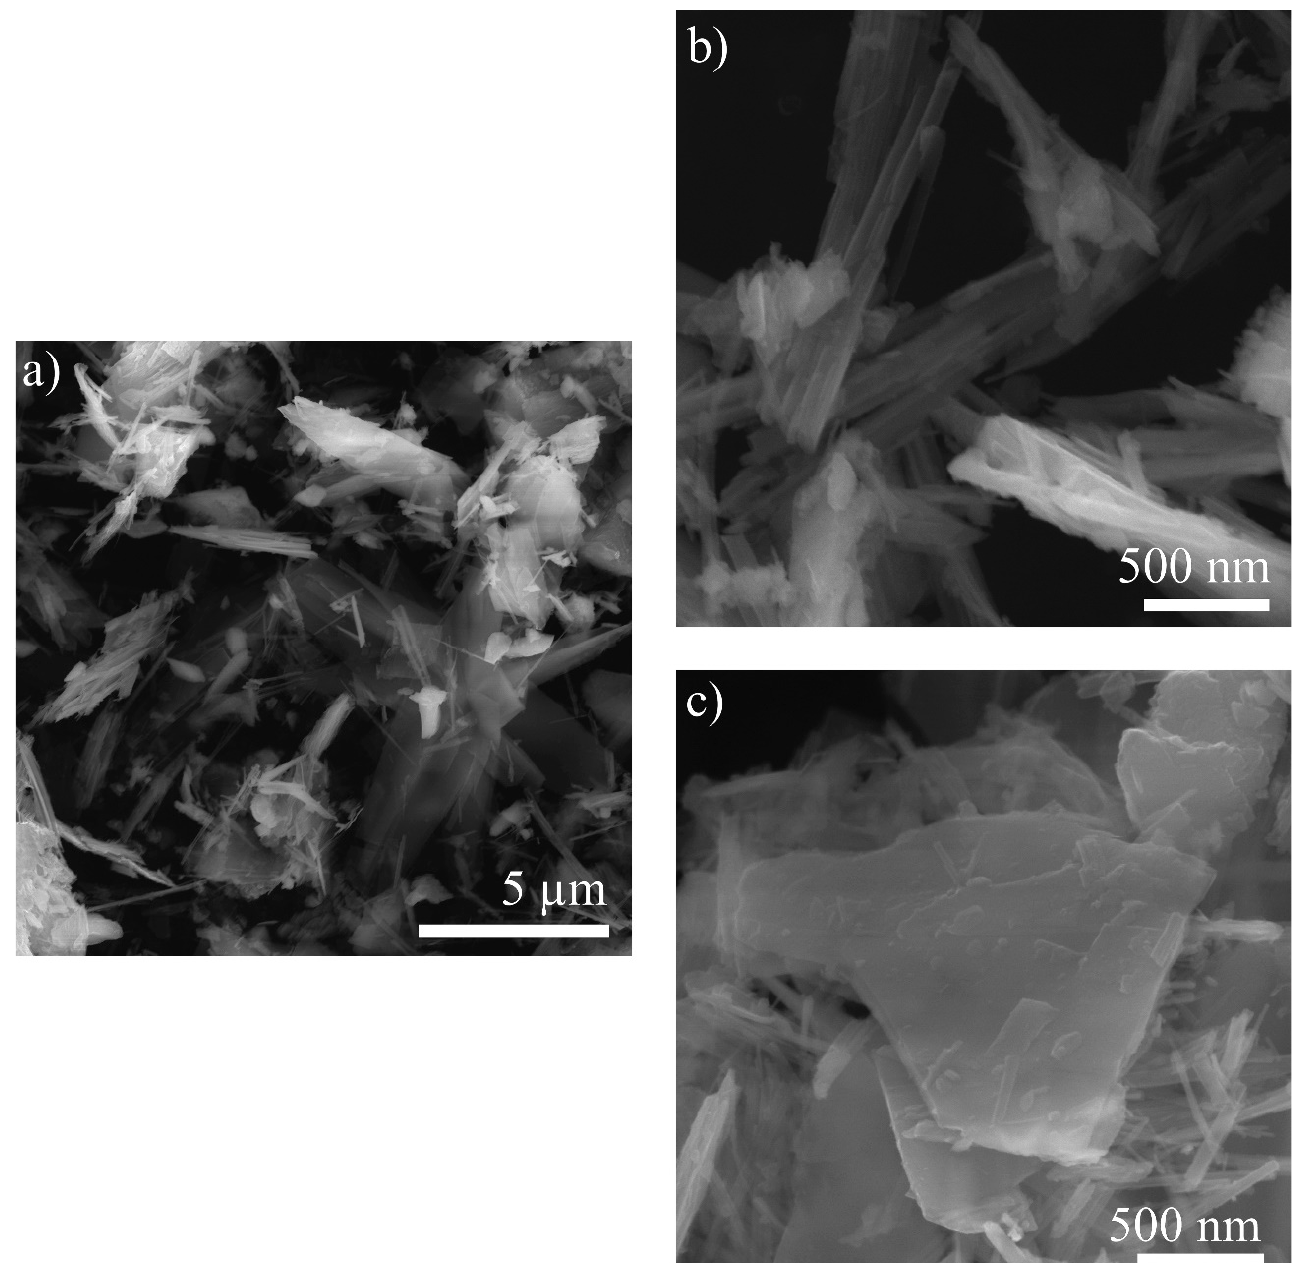
Figure 6. SEM images of ( a ) the 180 product illustrating both morphologies, ( b ) nanobelts and ( c ) plate ‐ like particles.